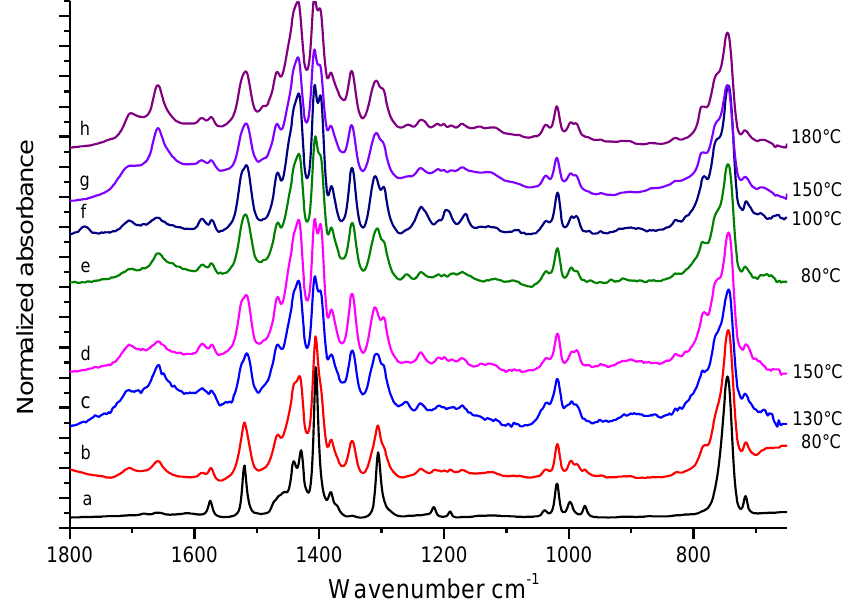
Figure 3. Experimental FT-IR spectra, in the 1800–700 cm −1 region, of TMP samples heated in air at different temperatures. Spectra were recorded two minutes after drop deposition. On the right side of the Figure, treatment temperatures ( ◦ C) are indicated. ( a ): pristine TMP. ( b – d ): samples treated in the absence of HSAG. ( e – h ): samples treated in the presence of catalytic amount of